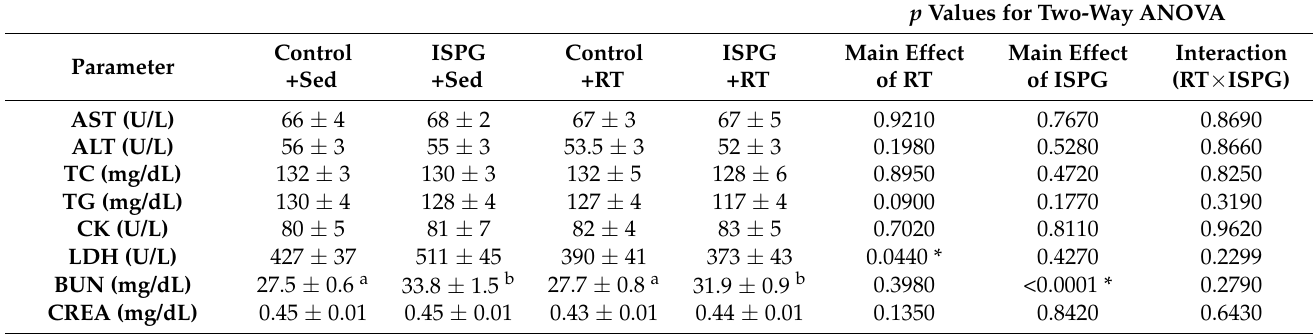
Table 3. Effects of ISPG and resistance training on biochemical assessments of serum at the end of the experiment.